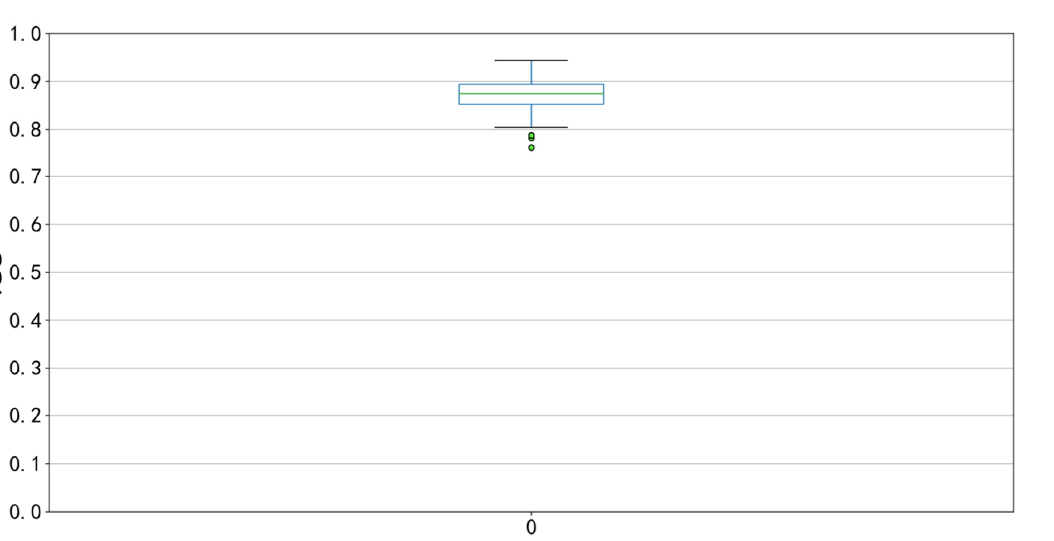
Figure 5. Box plot of ICC s of different vehicles.